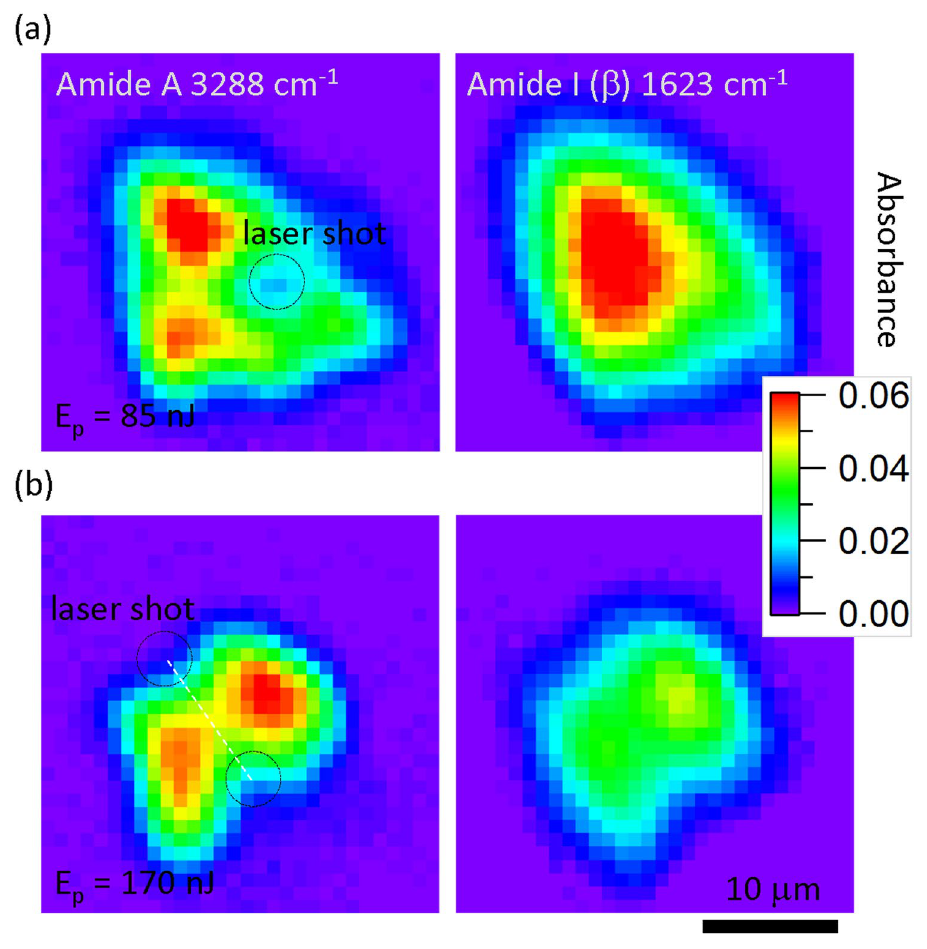
Figure 6. High resolution 1.9 μ m ATR maps of transverse (T) cross sections of silk ( Bombyx mori ) with laser 515 nm/230 fs irradiated spots; laser pulse energies, E p = 85 nJ ( a ) 170 nJ ( b ) on the sample; the polarisation was linear. The lateral step size was 0.5 μ m; as-measured pixelated absorbance maps are presented. Polarisation of incident light onto ATR prism was s (in the plane of image; along y-axis).